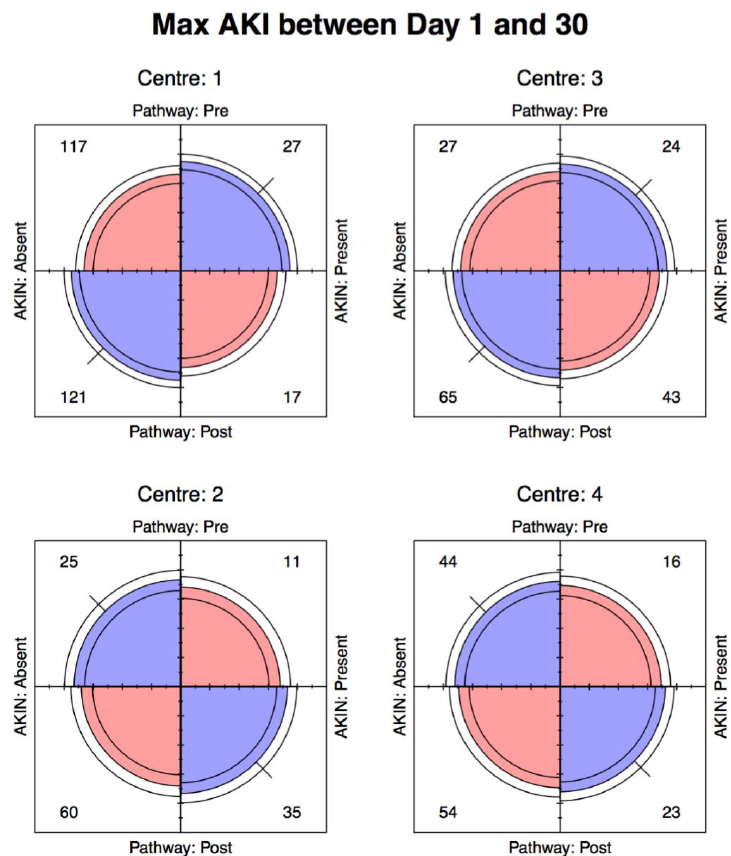
Figure 3. Four-fold Pl – t. Incidence of maximum AKI obtained between day 1 and day 30 post-op.